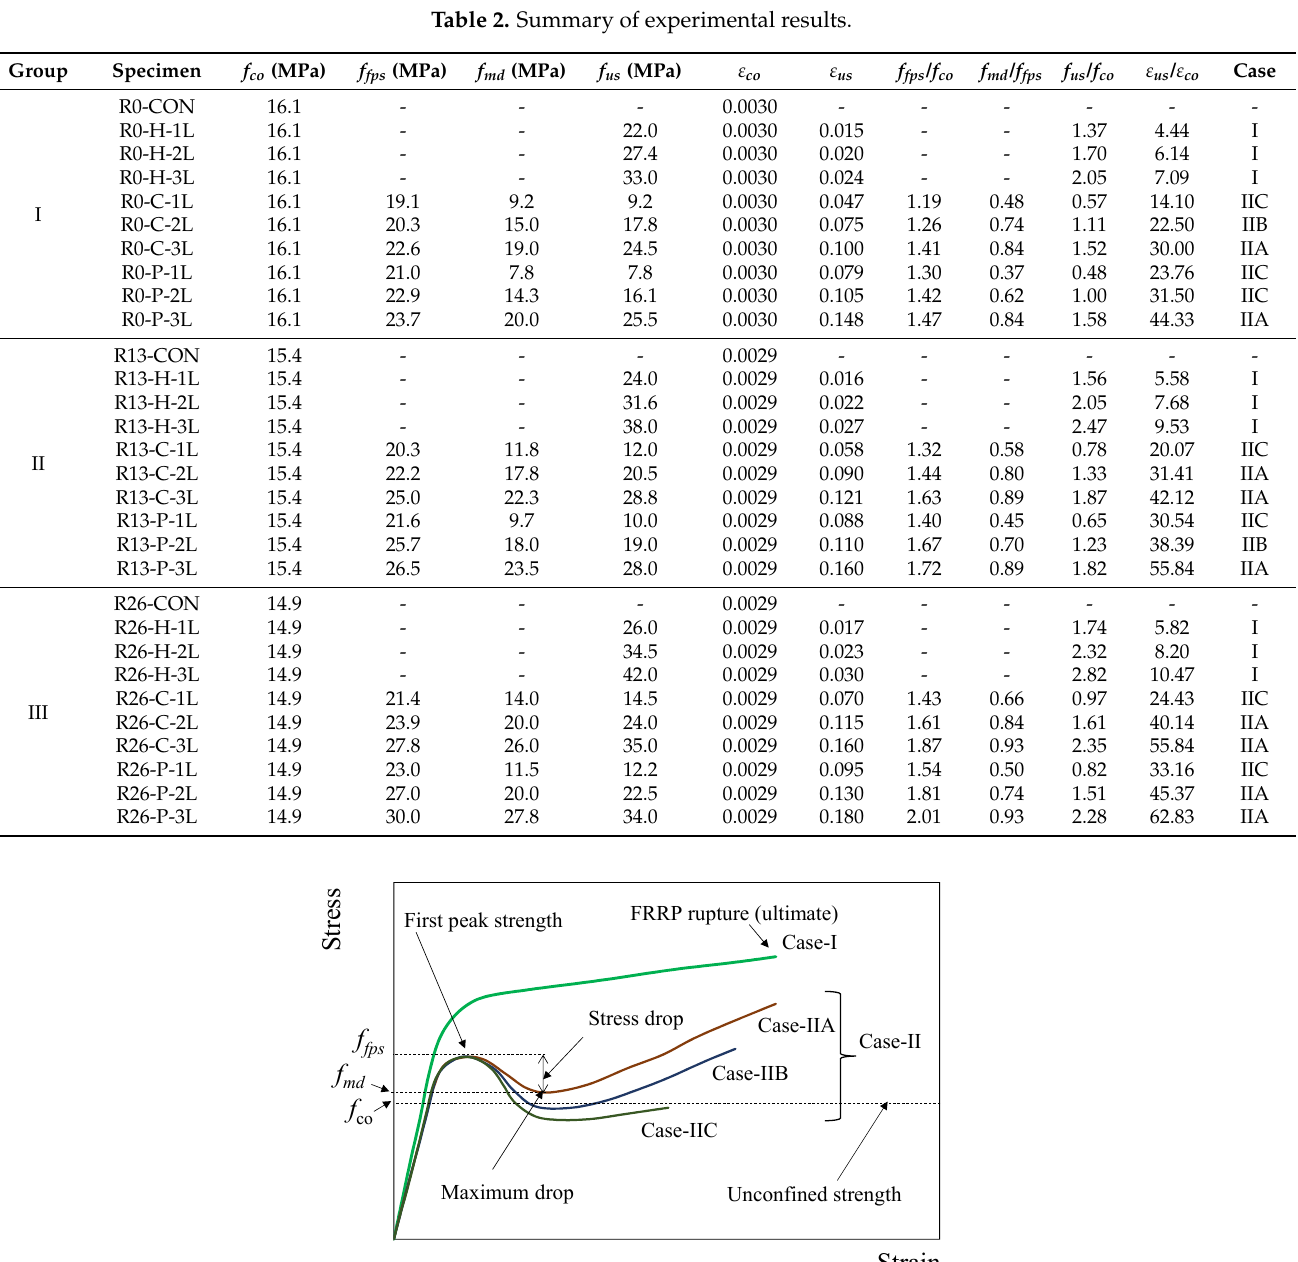
Figure 8. Typical axial stress versus strain behavior.